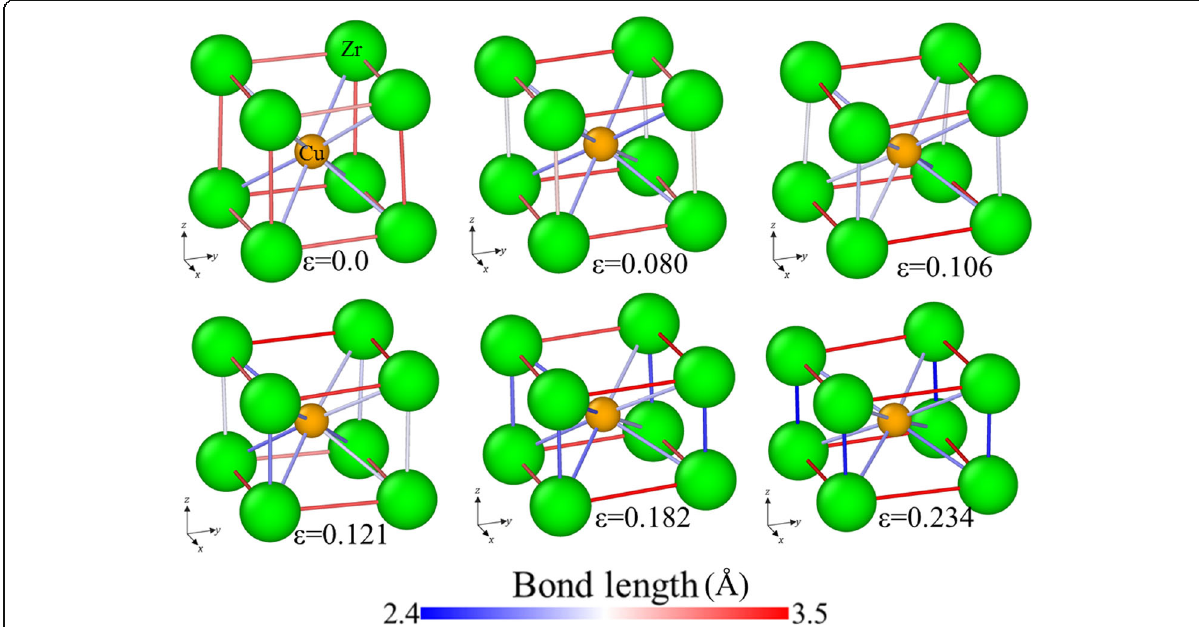
Fig. 10 Evolution of bond length for the sample [001] under compression, with bonds colored with its length